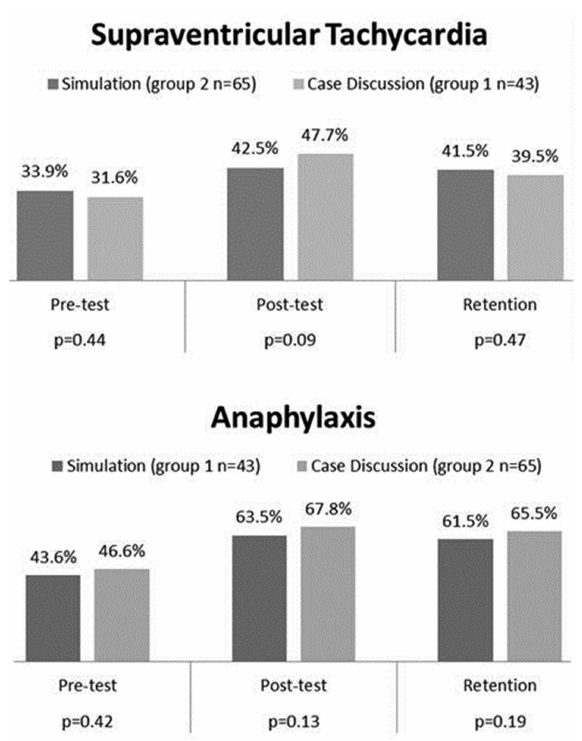
Figure 2 - Pretest, post-test and retention test results (mean scores) for each theme among the medical students, stratified by the teaching method.